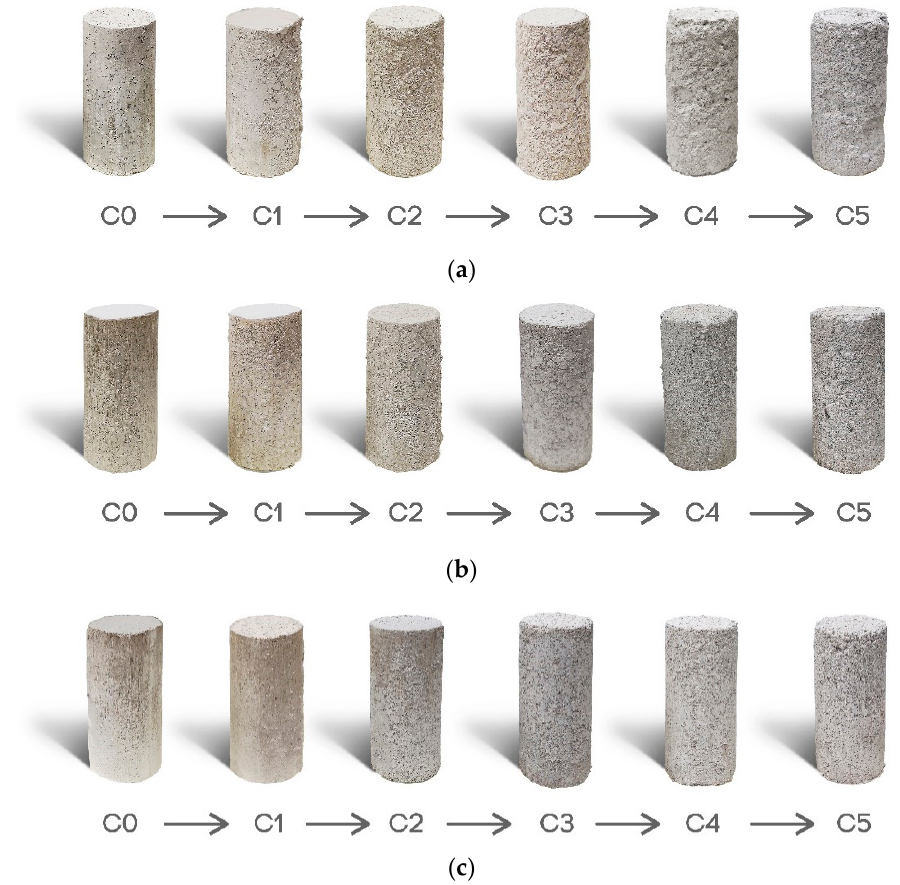
Figure 8. Treated and untreated soil samples from cycle 1 to cycle 5. ( a ) untreated, ( b ) agar-treated, and ( c ) sodium alginate-treated samples.